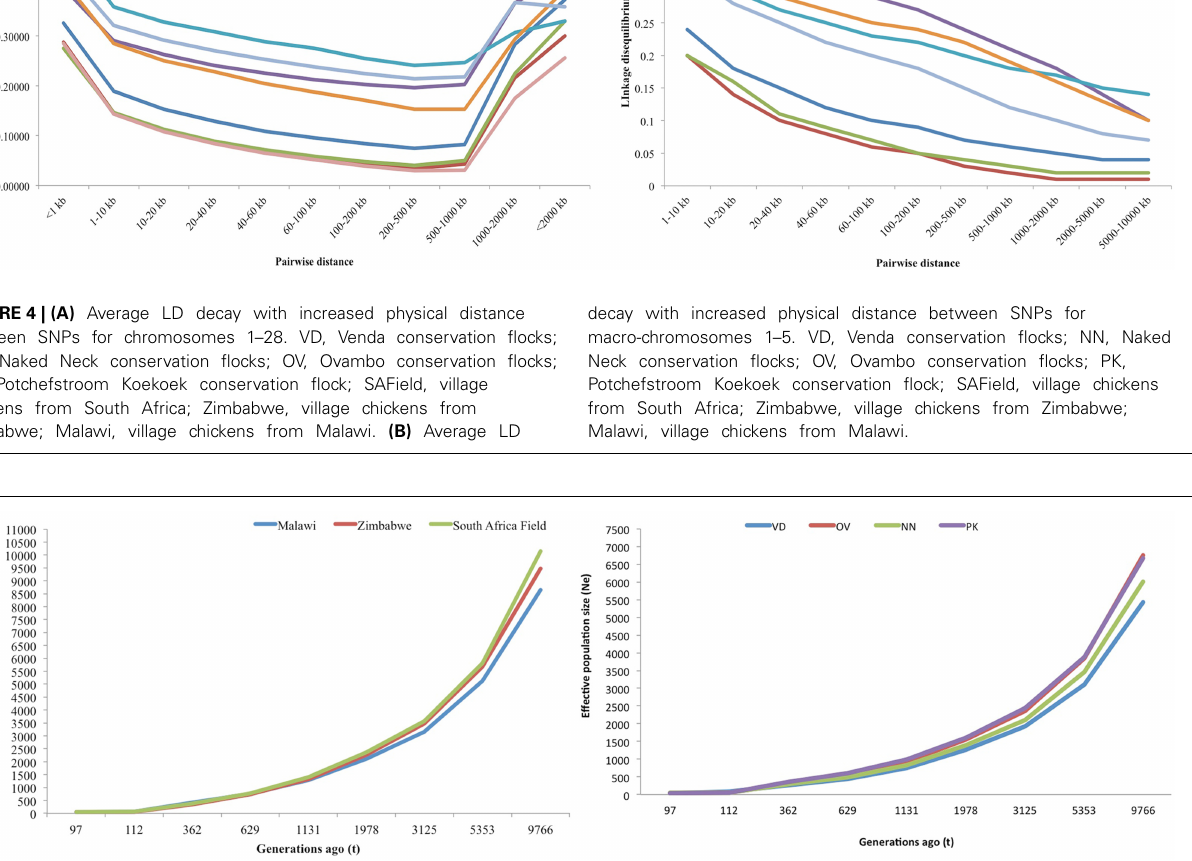
FIGURE 5 | (A) Trends in effective population size of village chicken flocks. (B) Trends in effective population size of conservation flocks. VD, Venda conservation flocks; NN, Naked Neck conservation flocks; OV, Ovambo conservation flocks; PK, Potchefstroom Koekoek conservation